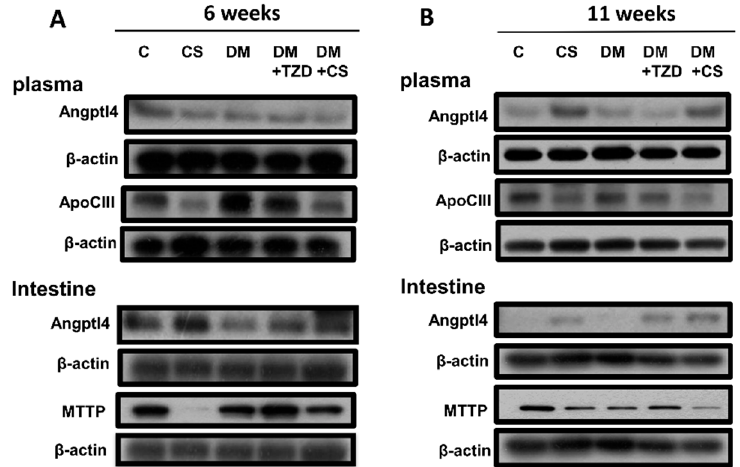
Figure 3. Effects of chitosan on metabolic signaling protein expression in the plasma and intestine of diabetic rats with different feeding durations. ( A ) 6-week feeding duration; ( B ) 11-week feeding duration. The protein expressions for Angptl4, ApoCIII, MTTP, and β -actin (internal control) were determined by Western blot analysis. The quantification is shown in Figure 4.